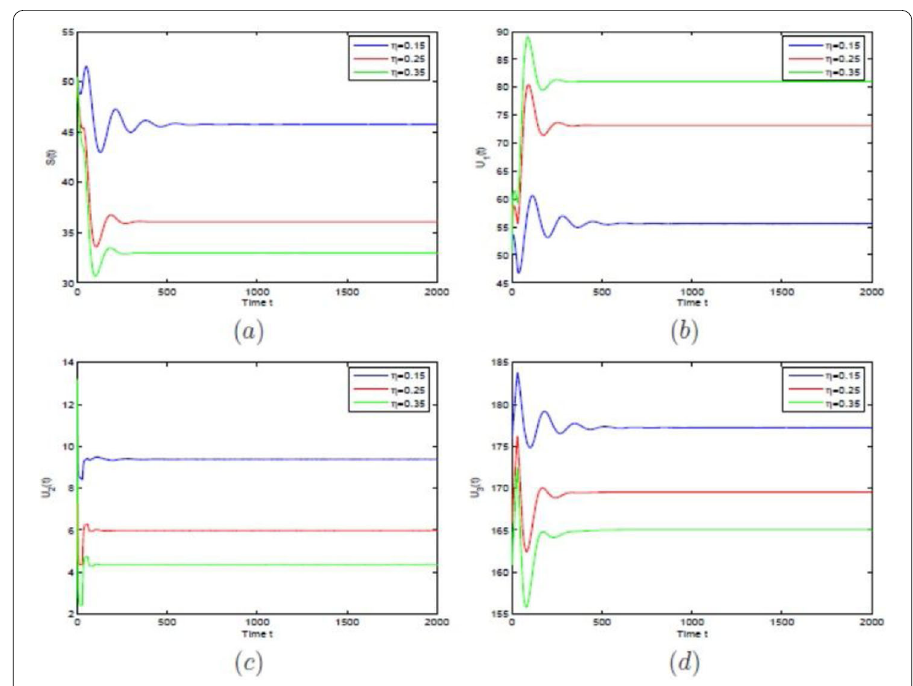
Figure 9 Effect of η on all classes for τ = 28.25: ( a ) S , ( b ) U 1 , ( c ) U 2 , ( d ) U